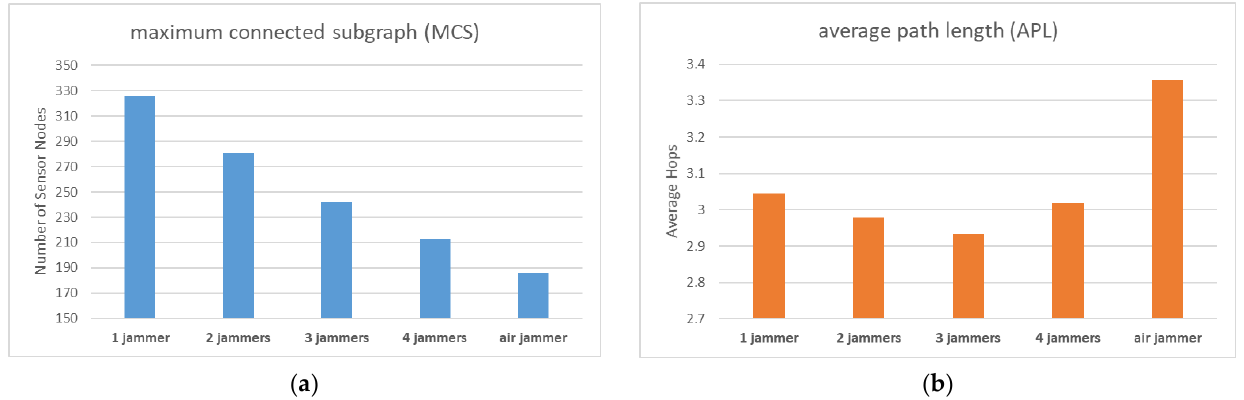
Figure 10. ( a ) MCS comparison of different numbers and locations of jammers; ( b ) APL comparison of different numbers and locations of jammers.